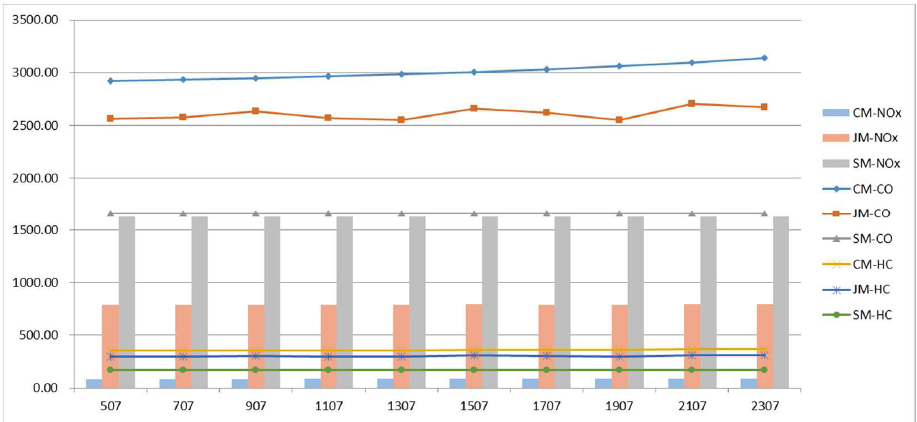
Figure 14. Pollutant emissions variations with parameter q .